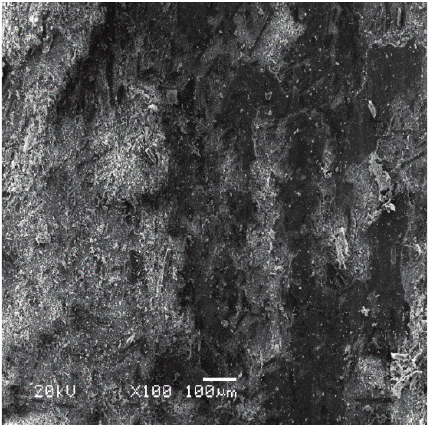
Figure 10: SEM picture of the actual contacting area under limit